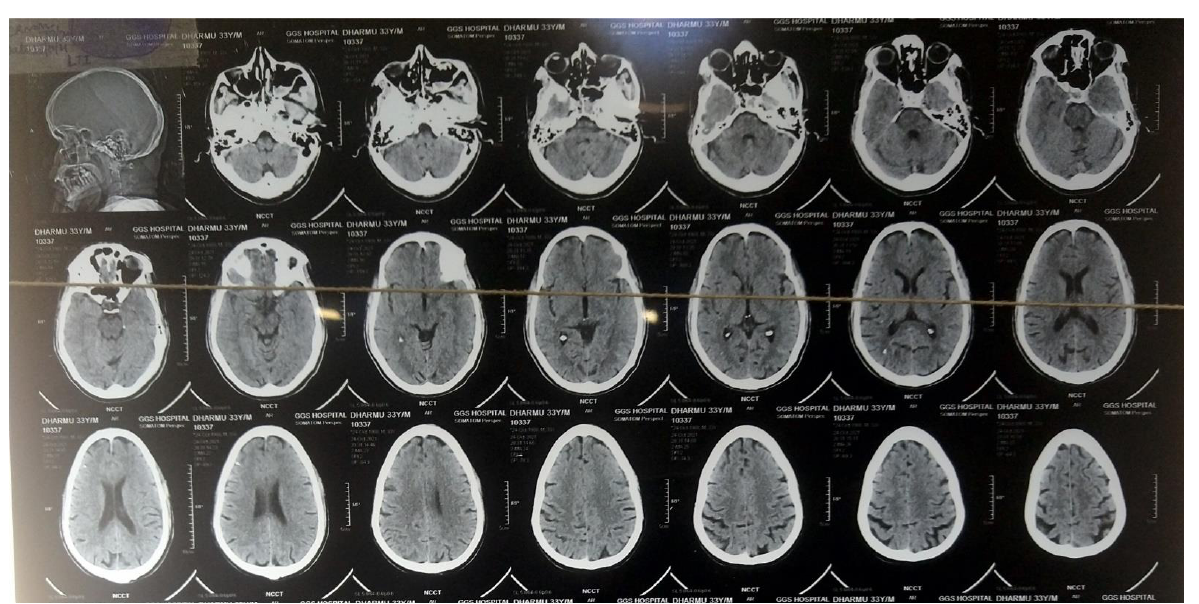
Figure 3. Computed tomographic (CT) scan image showing diffuse hypodensities consistent with meningitis.